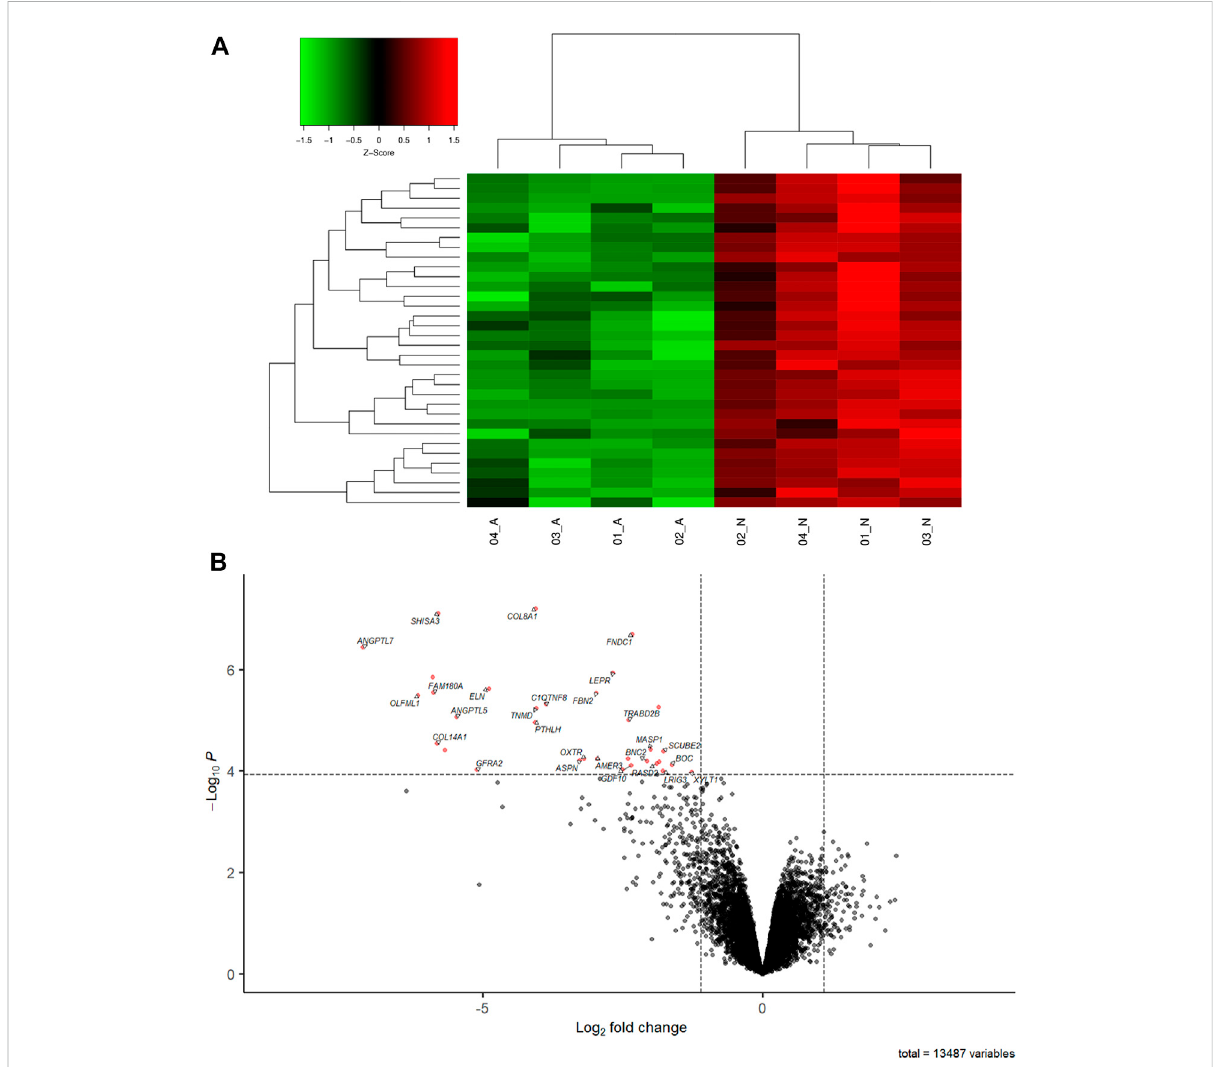
FIGURE 1 (A) Heatmap showing a hierarchical clustering of genes and samples of the DE genes between FHS-affected and control. The genes are presented in the rows and samples in the columns. Downregulated genes in the affected group are shown in red and upregulated in green. (B) Volcano plot showing the differentially expressed genes (red dot) in FHS-affected